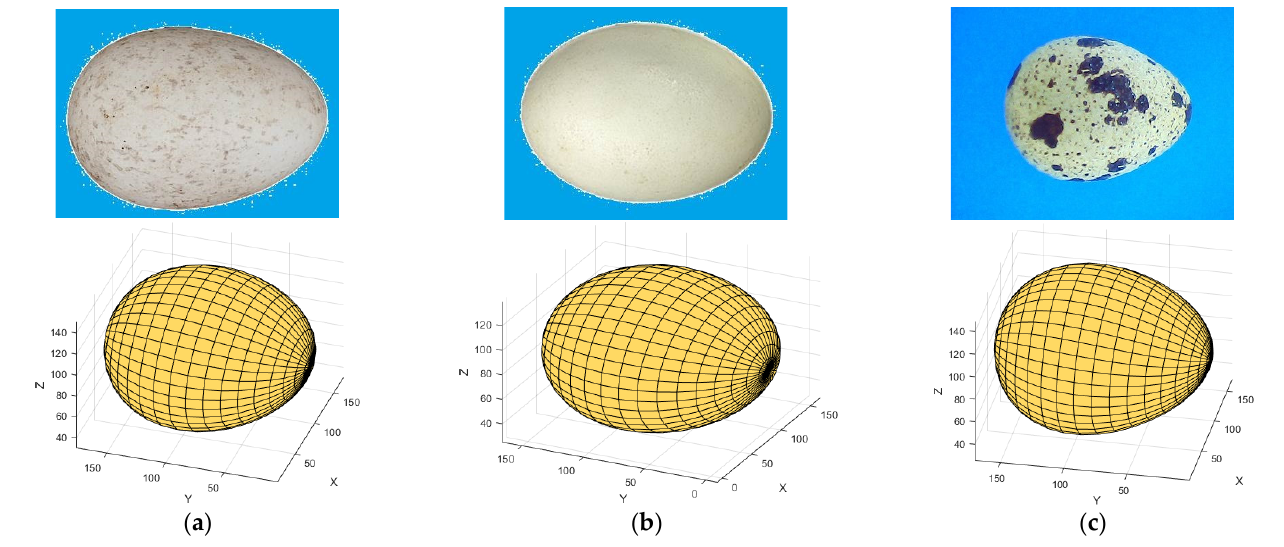
Figure 4. ( a ) Sparrow, ( b ) mallard, and ( c ) quail eggs and their 3D forms.